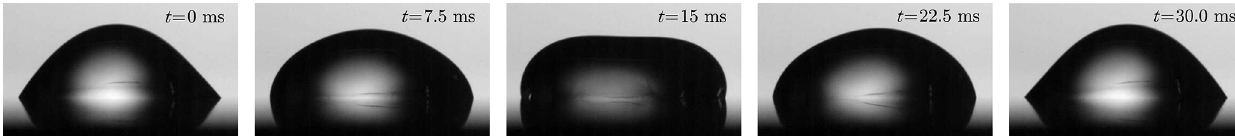
Figure 9. An oscillation cycle of an uncharged drop (second resonance mode) with a volume of V = 50µl surrounded by air and exposed to an electric field with a frequency of f = 17 . 56Hz at a field strength of ˆ E = 3 . 29kVcm − 1 . Similar to the present experiments, the electric field is oriented tangentially to the substrate. The oscillation is qualitatively the same as in the case of a droplet surrounded by oil. Only the amplitude of oscillation is significantly reduced, which is why it is not shown here. Videos of oscillating droplets surrounded by air and oil can be found as the Supplement of Löwe (2020b, a) and used under https://creativecommons.org/licenses/by/3.0/de/deed.en (last access: 30 December 2020, CC BY 3.0 DE).